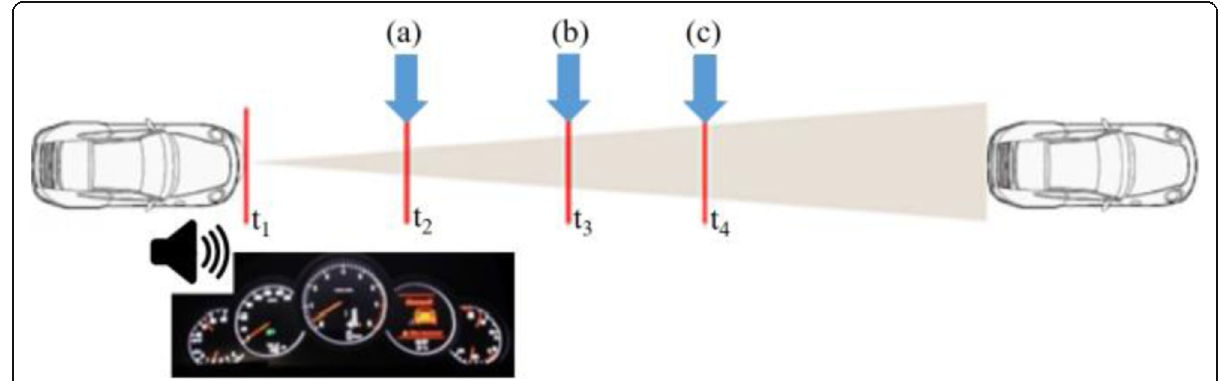
Fig. 1 Non-adaptive, close-to-series system; ( a , t 2 ) optical and acoustic warning; ( b , t 3 ) brake pulse; ( c , t 4 ) partial